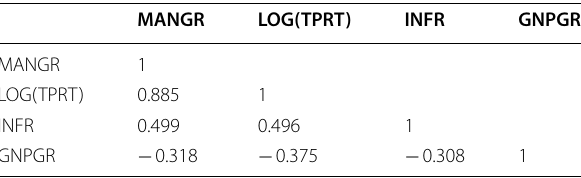
Table 2 Result of correlation matrix